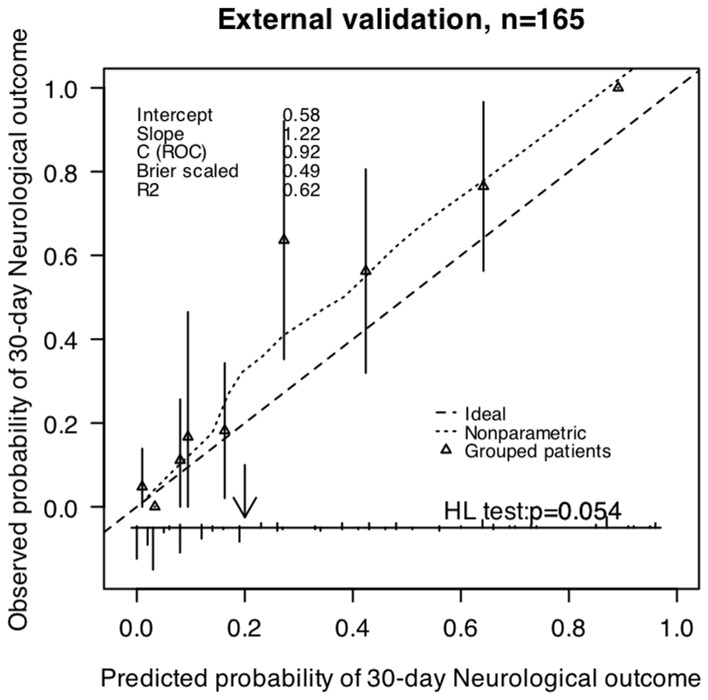
Validation of the prognostic models for 30-day outcome in validation patients (n = 165).The smooth dash curves reflect the relation between observed probability of outcome and predicted probability of outcome. The triangles indicate the observed frequencies by deciles of predicted probability.